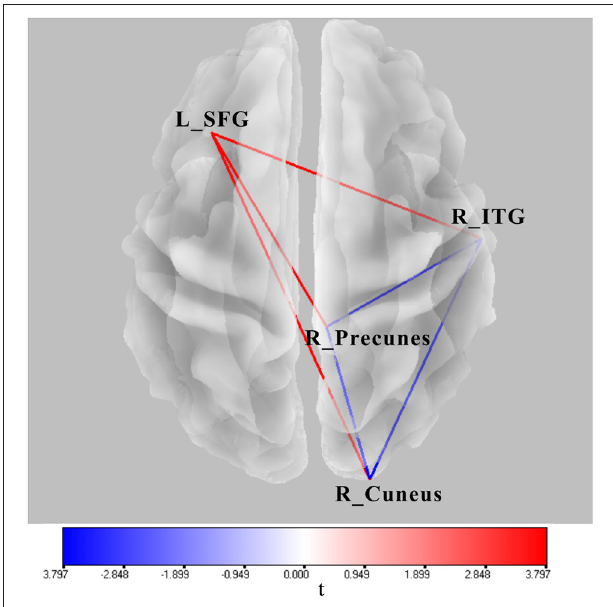
FIGURE 6 | Wire diagram showing significant FC differences between AV and A conditions and between AV and A + V (| t| min > 3.73, p < 0.05) (blue and red wires) based on physiological lagged connectivity measures by cortical eLORETA signals. These results correspond to theta oscillations (4–8Hz). The red wire denotes increased connectivity; the blue wire denotes decreased connectivity. L, left; R, right; SFG, superior frontal gyrus; ITG, inferior temporal